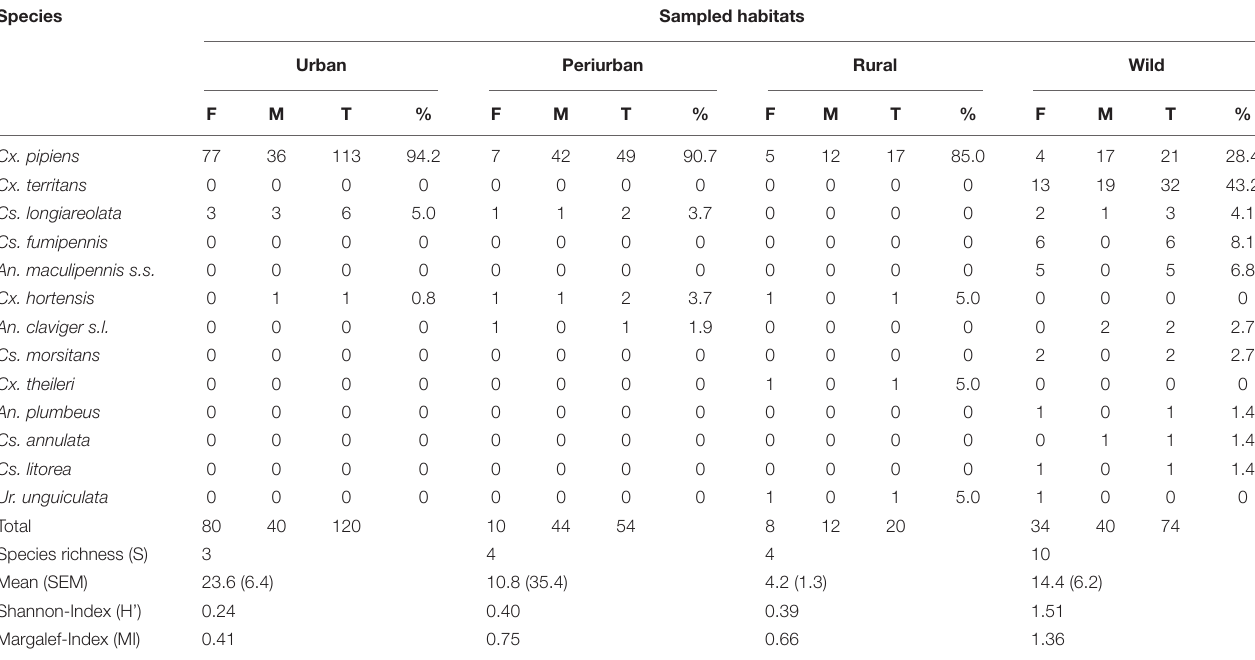
∗ F = females, M = Males, and T =